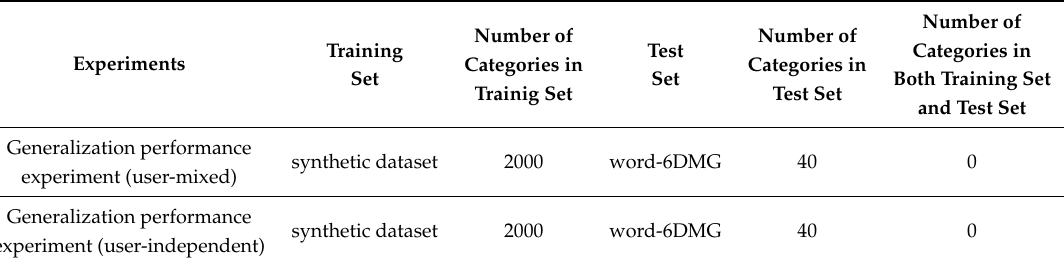
Table 5. Experimental settings for generalization performance experiments.